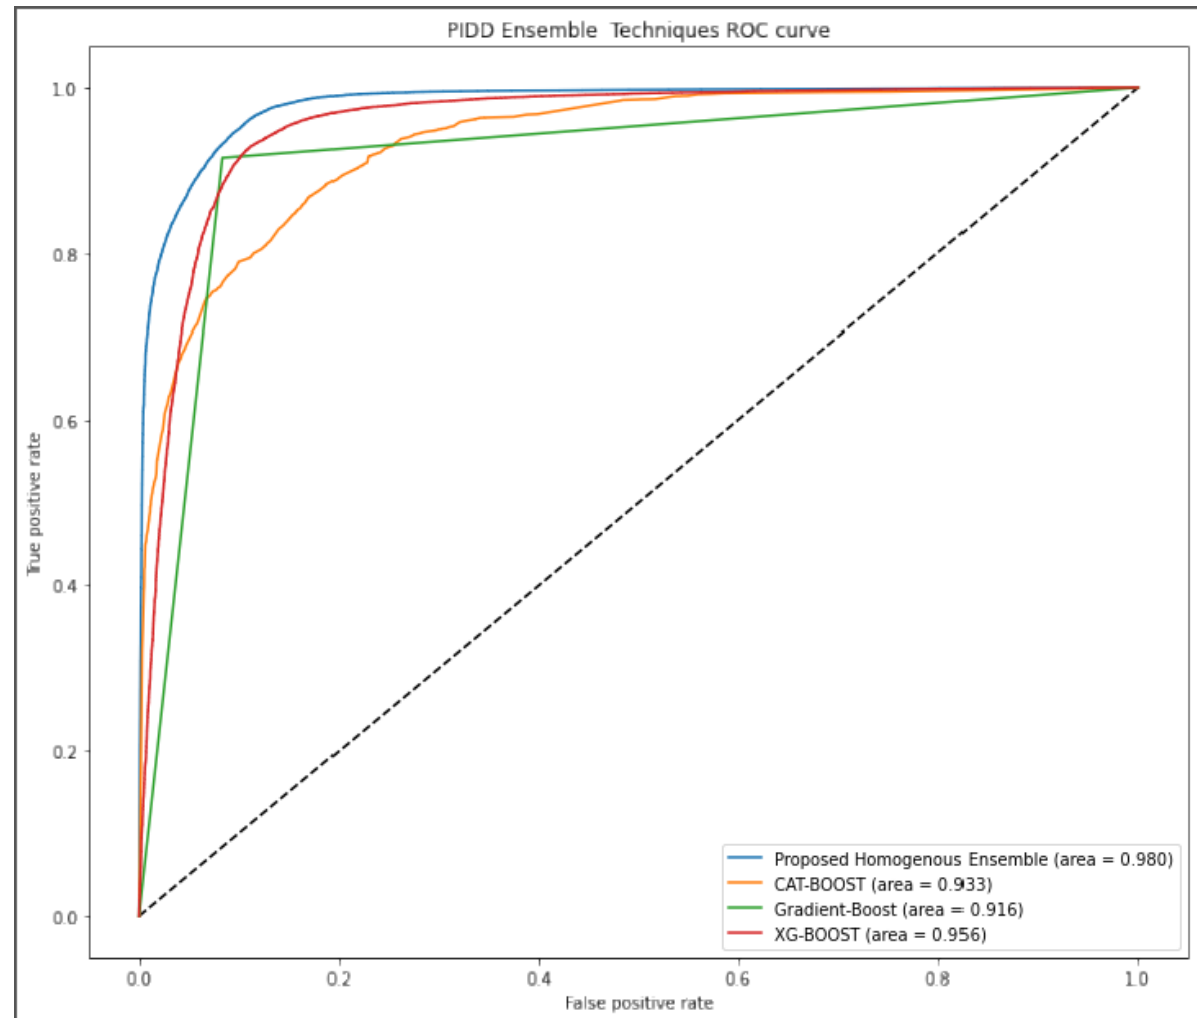
Figure 5. PIDD ROC curve: proposed homogenous against other ensemble techniques.